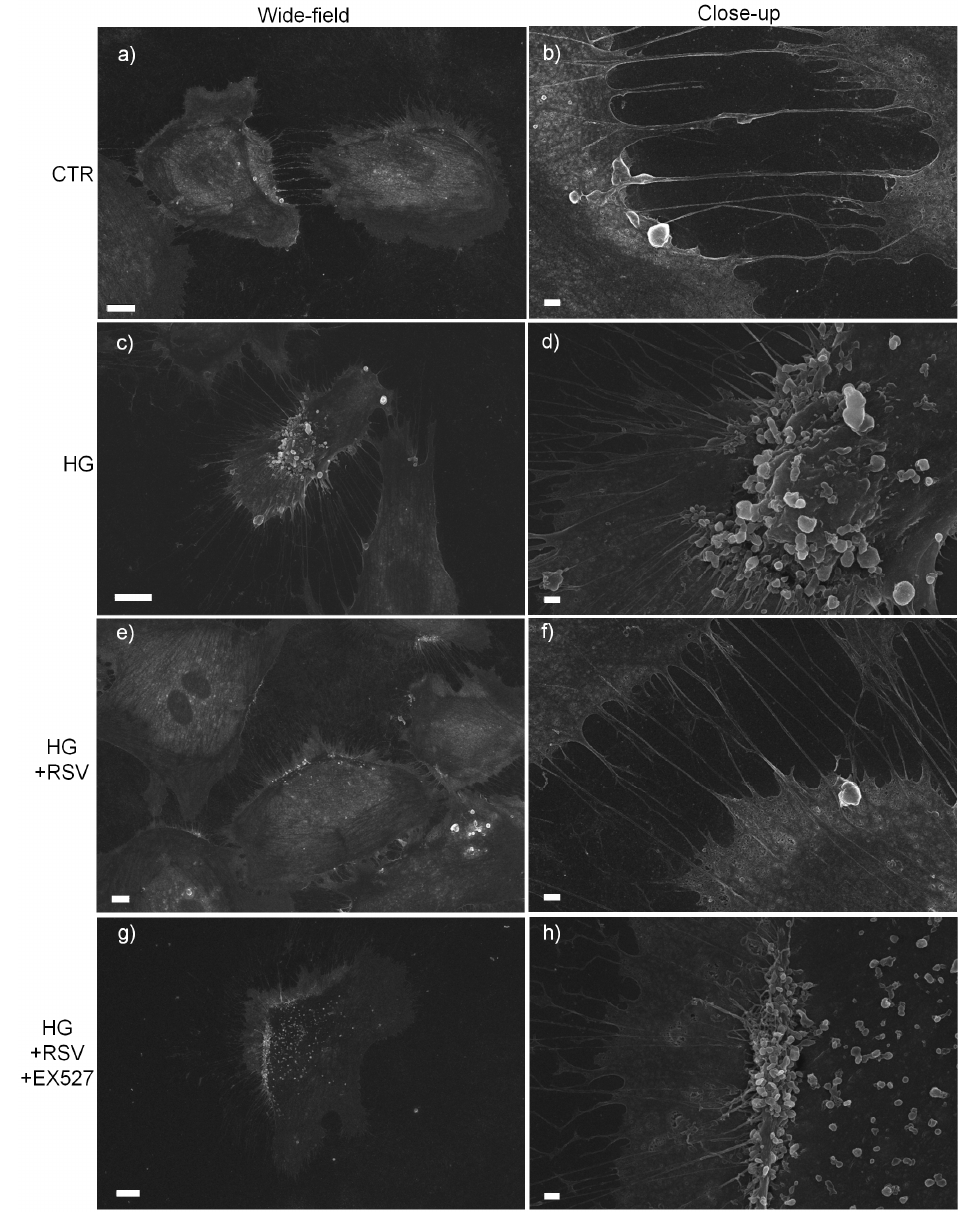
Figure 3. E ff ect of a 24-h treatment with either resveratrol alone (5 µ M) or resveratrol + EX527 (5 µ M and 13.4 µ M, respectively) on cell membrane response of high glucose-challenged HUVECs. Representative scanning electron microscope images are shown. Bars: 10 µ m ( a , c , e , g ), 1 µ m ( b , d , f , h ). Abbreviations: CTR—vehicle; HG—high glucose; HG + RSV—high glucose + resveratrol; HG + RSV + EX527—high glucose + resveratrol + EX527.